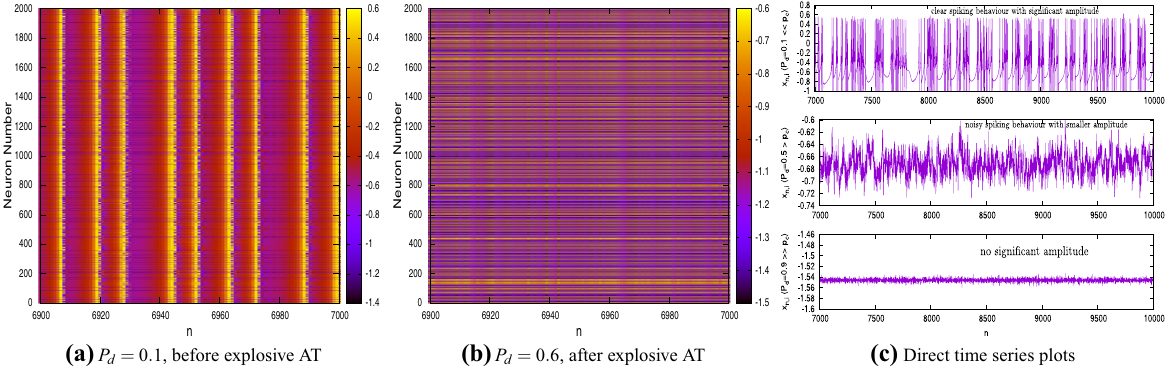
Figure 7. Time series diagrams showing the dynamical behaviour of each of the N = 2000 neurons (plotted on the ordinate) with time (plotted on the abscissa); ( a ) Dynamics for the system before AT ( P n = 0.5 , g m = 0.85 and P d = 0.1 ). ( b ) Dynamics for the system after AT ( P n = 0.5 , g m = 0.85 and P d = 0.6 ). ( c ) dynamics of randomly selected neurons for different values of P d . In all cases, D = 0.05 , while P n = 0.5 and g m = 0.85 .